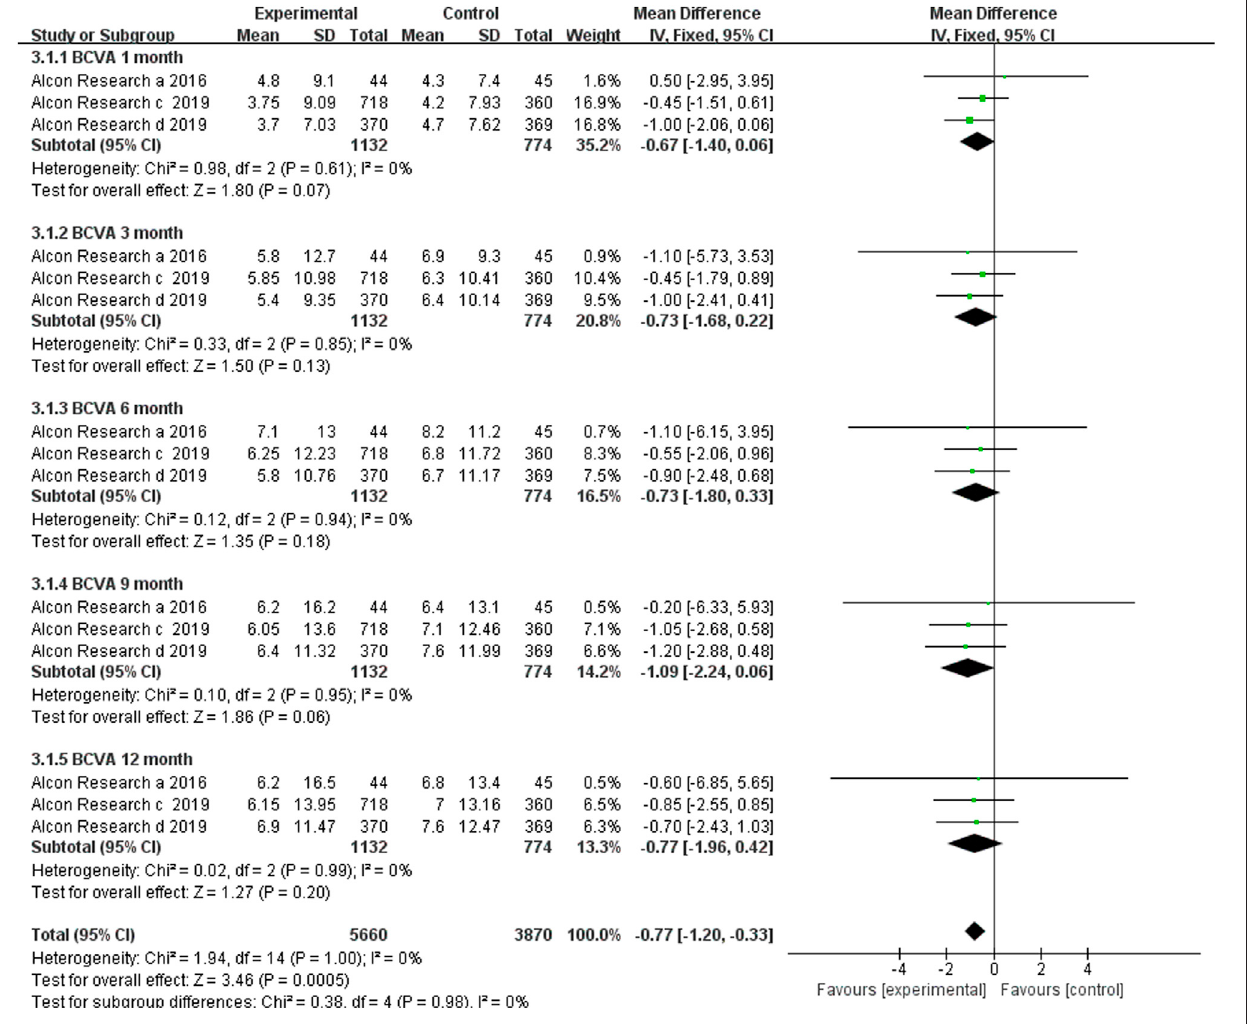
Frontiers in Pharmacology |